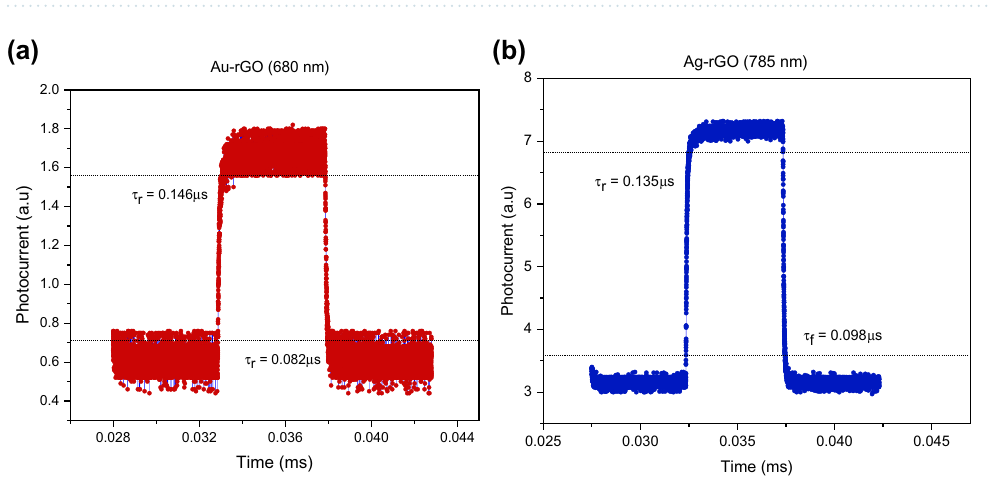
Figure 7. Photoresponse of all devices; Au-rGO, Ag-rGO & rGO PDs illuminated by ( a – c ) 680 nm laser and ( d – f ) 785 nm at different laser powers.